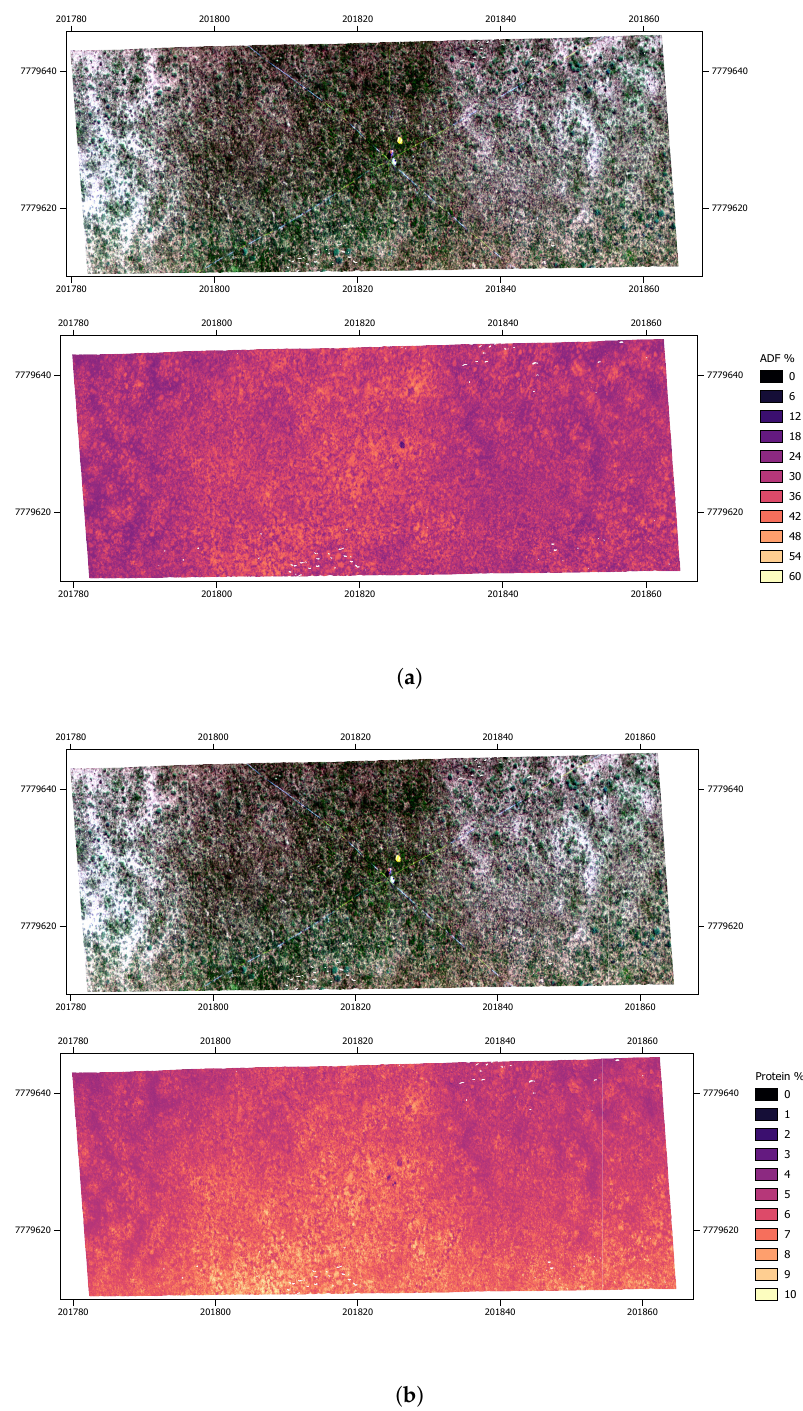
Figure 9. Examples of robust regression modelling of acid detergent fibre ( a ) and crude protein ( b ) for an area of Mitchell grassland. The top map of each is a reference true colour orthomosaic image for